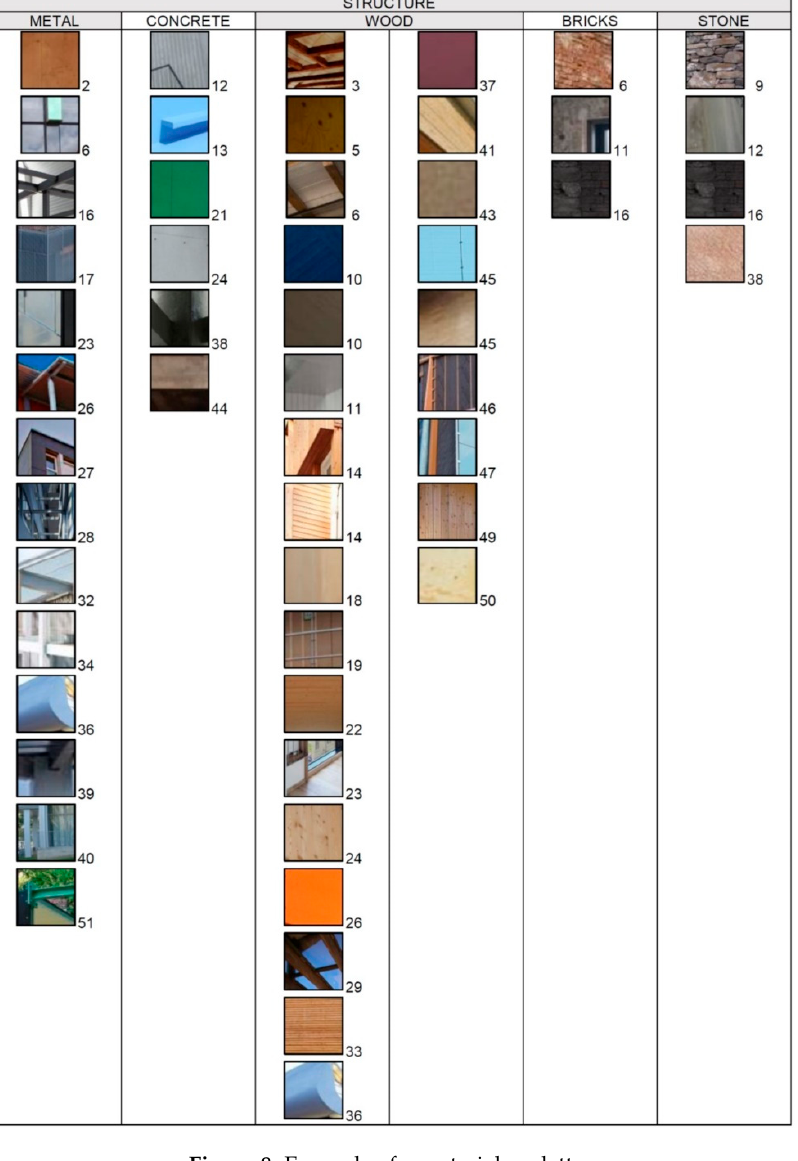
Figure 8. Example of a materials palette.